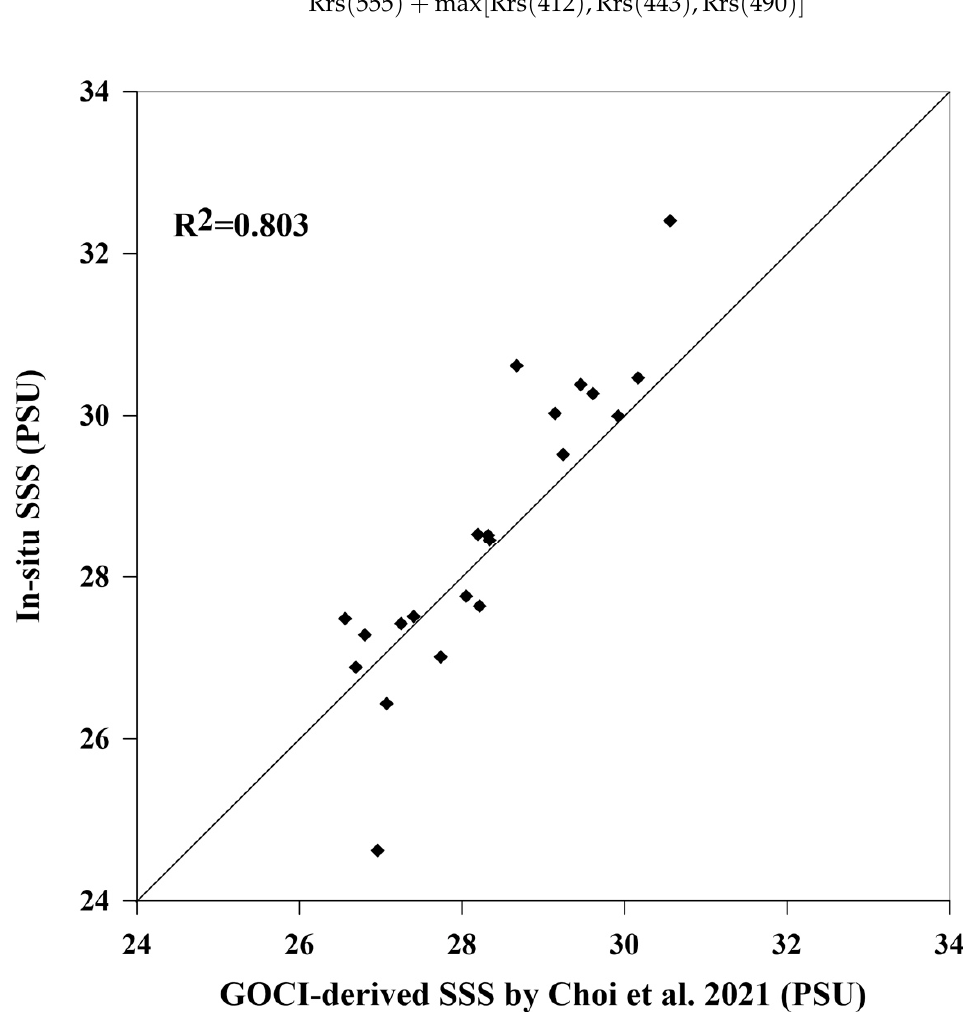
Figure 2. Comparison of the results obtained using the algorithm in this study with in situ SSS using 21 measurements from a test set for GOCI-derived SSS.